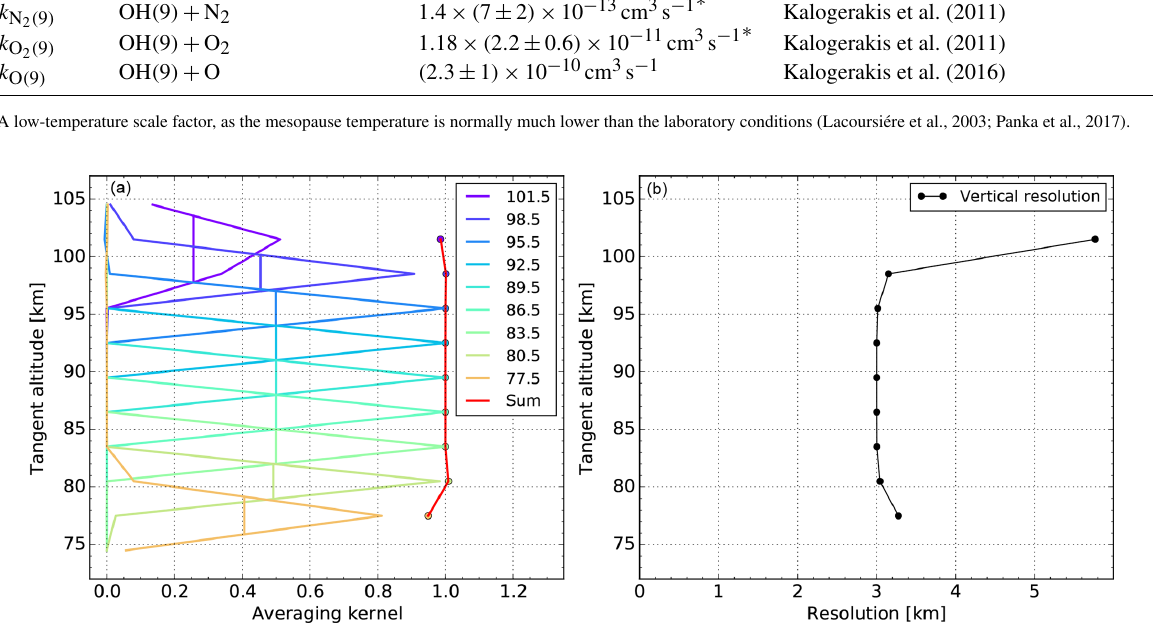
and k O represent the quenching coefficients of , k O 2 2